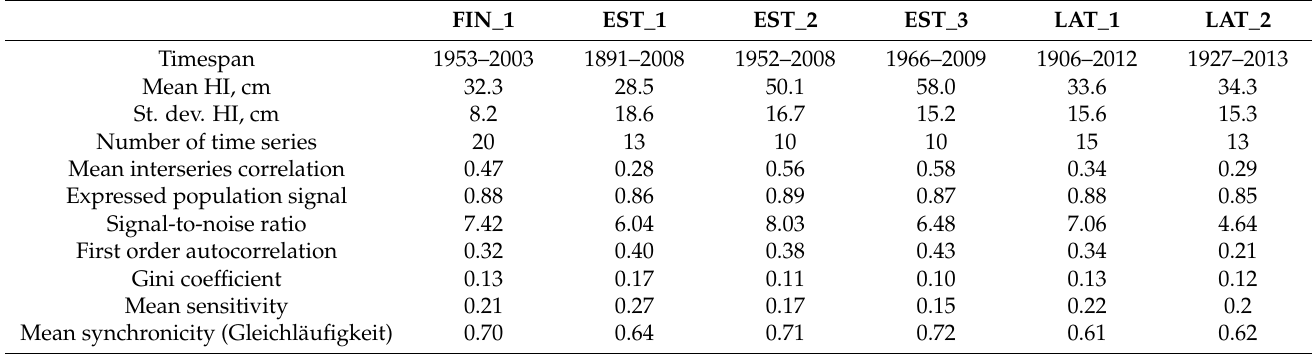
Table 3. Statistics of the cross-dated datasets of time series of height increment (HI) of Scots pine from the stands from the north-eastern Baltic Sea